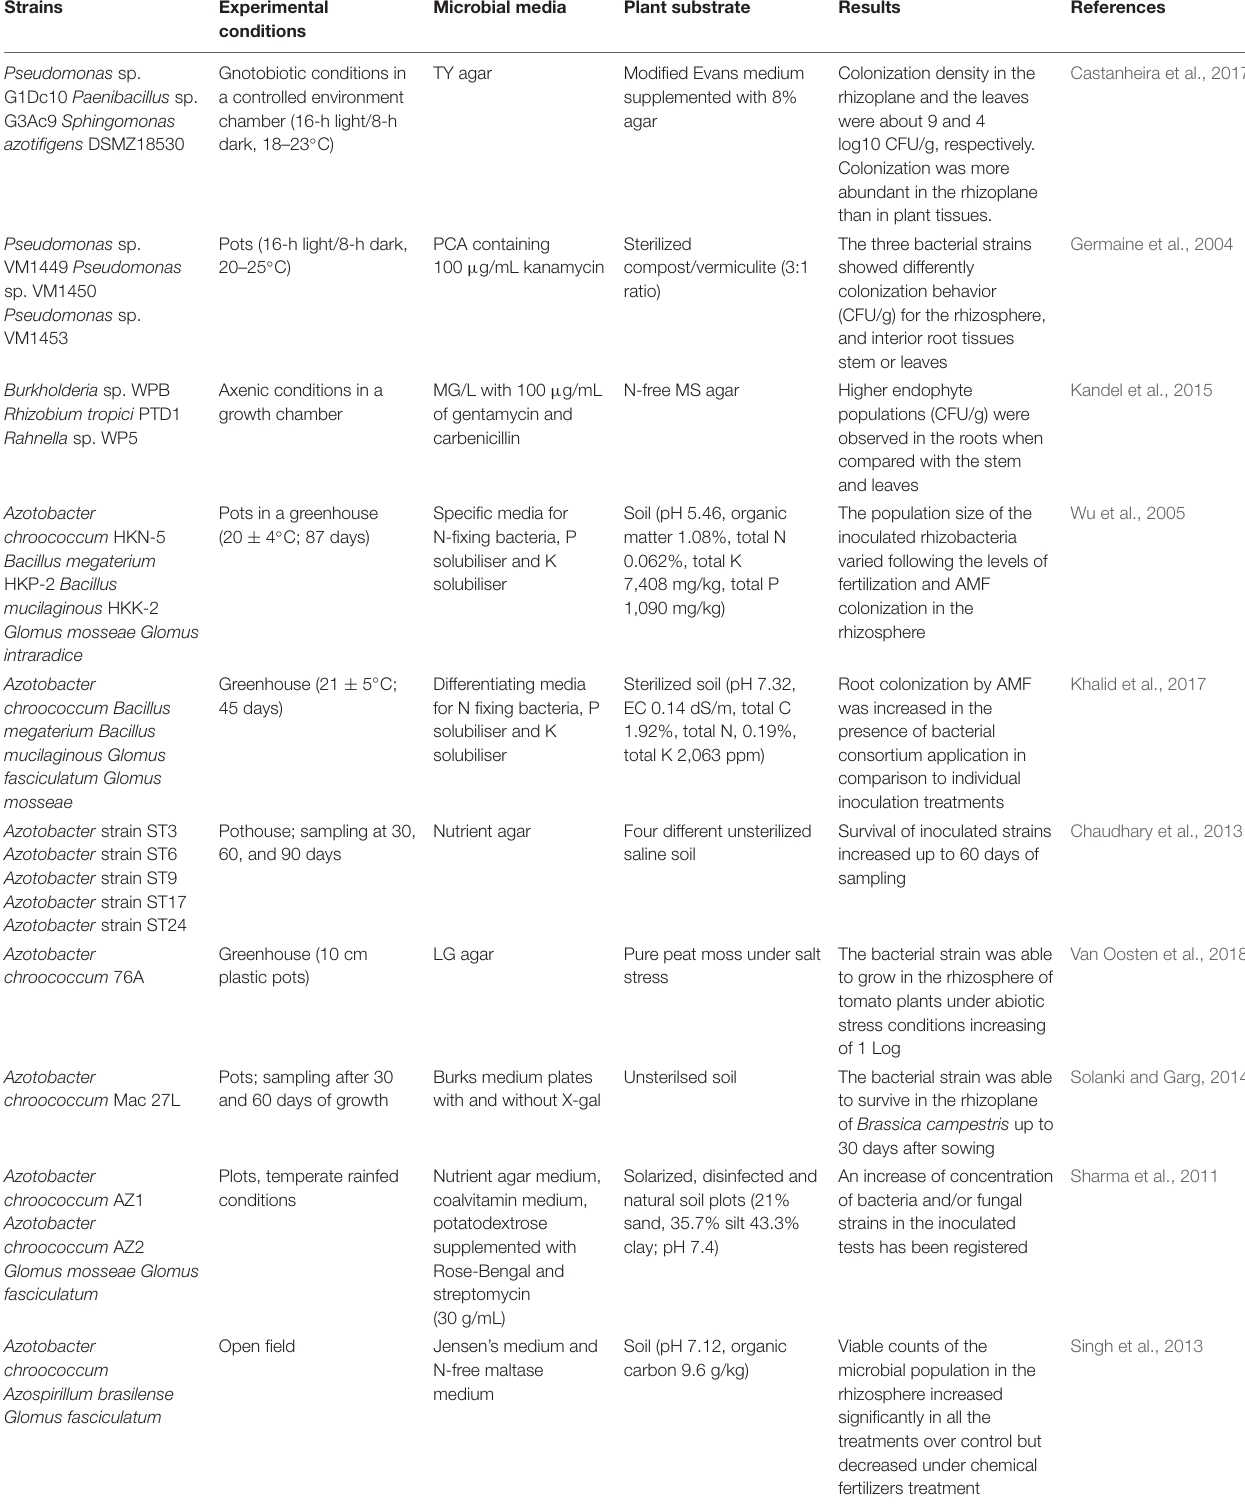
TABLE 1 | Culture-dependent approach used to monitor soil